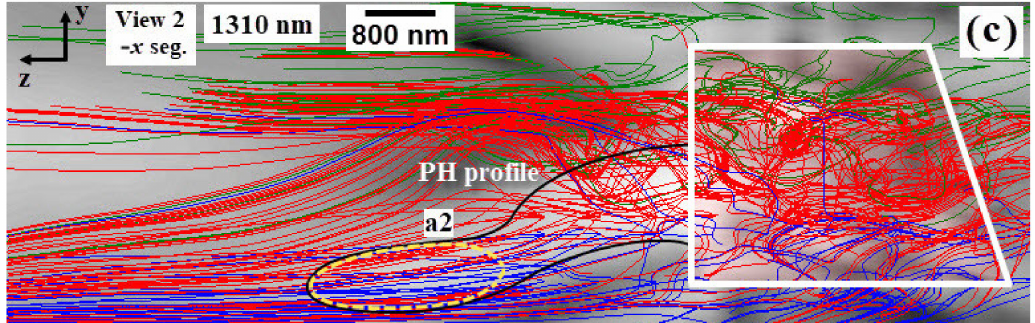
Figure 4. ( a ) Diagram of view 1 and view 2 segments and 3D Poynting vector distributions for ( b ) view 1 + x segment and ( c ) view 2 − x segment of the model with the irradiation at the wavelength of 1310 nm. Orientations of the particle in Figure 4b,c are reversed due to the change of frames of references for the observers in view 1 and view 2 as shown in Figure